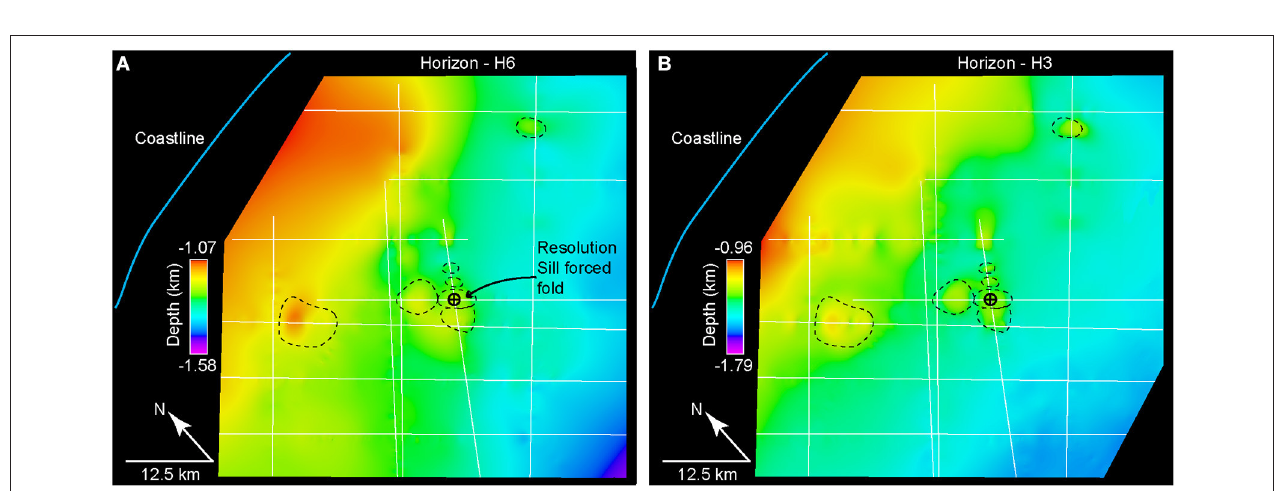
FIGURE 7 | Plot of amplitude across the fold, at H3, measured directly from the seismic reflection data (i.e., Figure 5C ). We also show a range of sill thicknesses, for different seismic interval velocities, across the intrusion where TS and BS can be distinguished; a sill thickness profile considering a seismic interval velocity of 5.2km s − 1 is particularly highlighted because this is the average interval velocity for the upper 50m of the intrusion where it is intersected by the Resolution-1 borehole. Thicknesses are not shown where the sill corresponds to a tuned reflection package along the inclined limbs, but we do highlight the maximum (max.) limit of separability and minimum (min.) limit of visibility for the sill. Note the lateral offset of F max and T max .